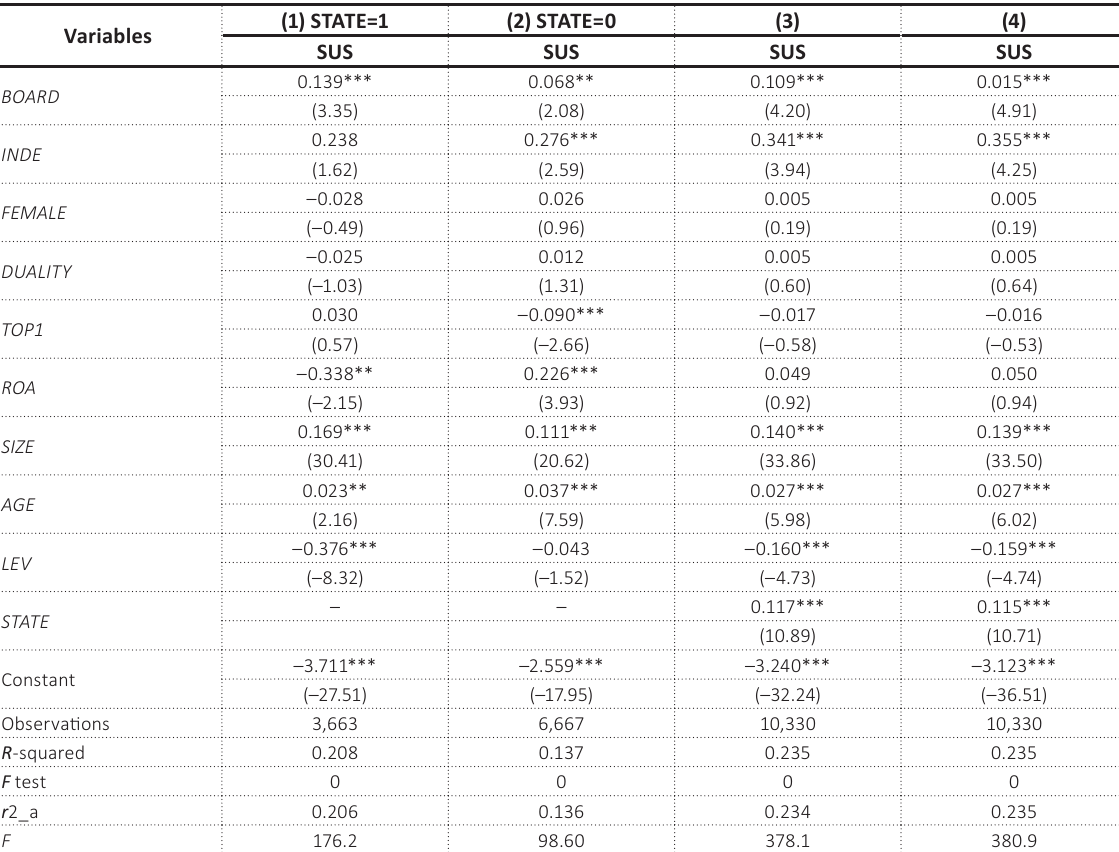
Source: Developed by the